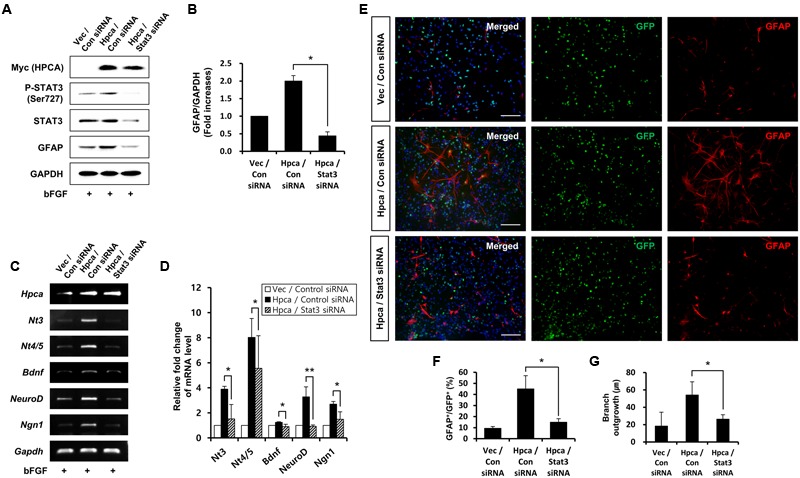
Effect of STAT3 downregulation on astrocytic differentiation of HNPCs. (A) HNPCs were transfected with pMSCV-IRES-EGFP or pMSCV-Hpca-myc-IRES-EGFP for 48 h and then transfected with control siRNA or Stat3 siRNA for 72 h. Proteins were analyzed in western blotting with anti-Myc, anti-p-STAT3 (Ser727), anti-STAT3, anti-GFAP, and anti-GAPDH. (B) Graph shows mean densities as fold increases from three independent experiments (means ± SD). ∗p < 0.01 compared with Hpca/control siRNA. (C,D) mRNA levels of neurotrophins and proneural bHLH transcription factors were analyzed by RT-PCR (C) and real-time PCR (D). Data are means ± SD of three independent experiments. ∗p < 0.05; ∗∗p < 0.01 compared with Hpca/control siRNA. (E) Cells were transduced with EGFP vector or Hpca-myc-EGFP for 48 h and then transfected with control siRNA or Stat3 siRNA for 72 h. Fixed cells were immunostained with anti-GFP (green) and anti-GFAP (red). Bar, 100 μm. (F) Graph shows the percentages of GFAP-positive cells. GFAP-positive cells among GFP-positive cells were counted under fluorescence microscopy. The proportions of GFAP-positive cells were determined in randomly selected areas from five cultures (means ± SD). ∗p < 0.05 compared with the Hpca/control siRNA. (G) Branch lengths were measured in randomly selected areas from five cultures (means ± SD). ∗p < 0.05 compared with the Hpca/control siRNA.